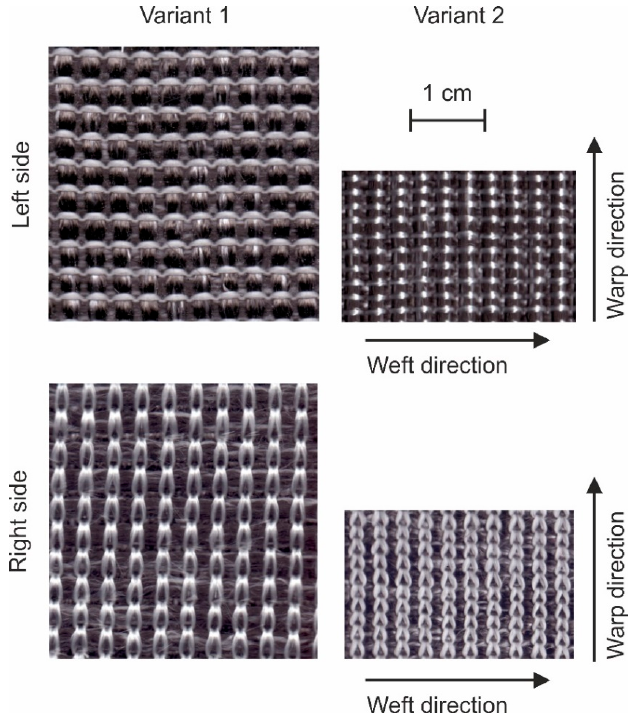
Figure 5. Surface of the biaxial reinforced weft-knitted fabrics with 10 warp und 10 weft yarns on the same scale.